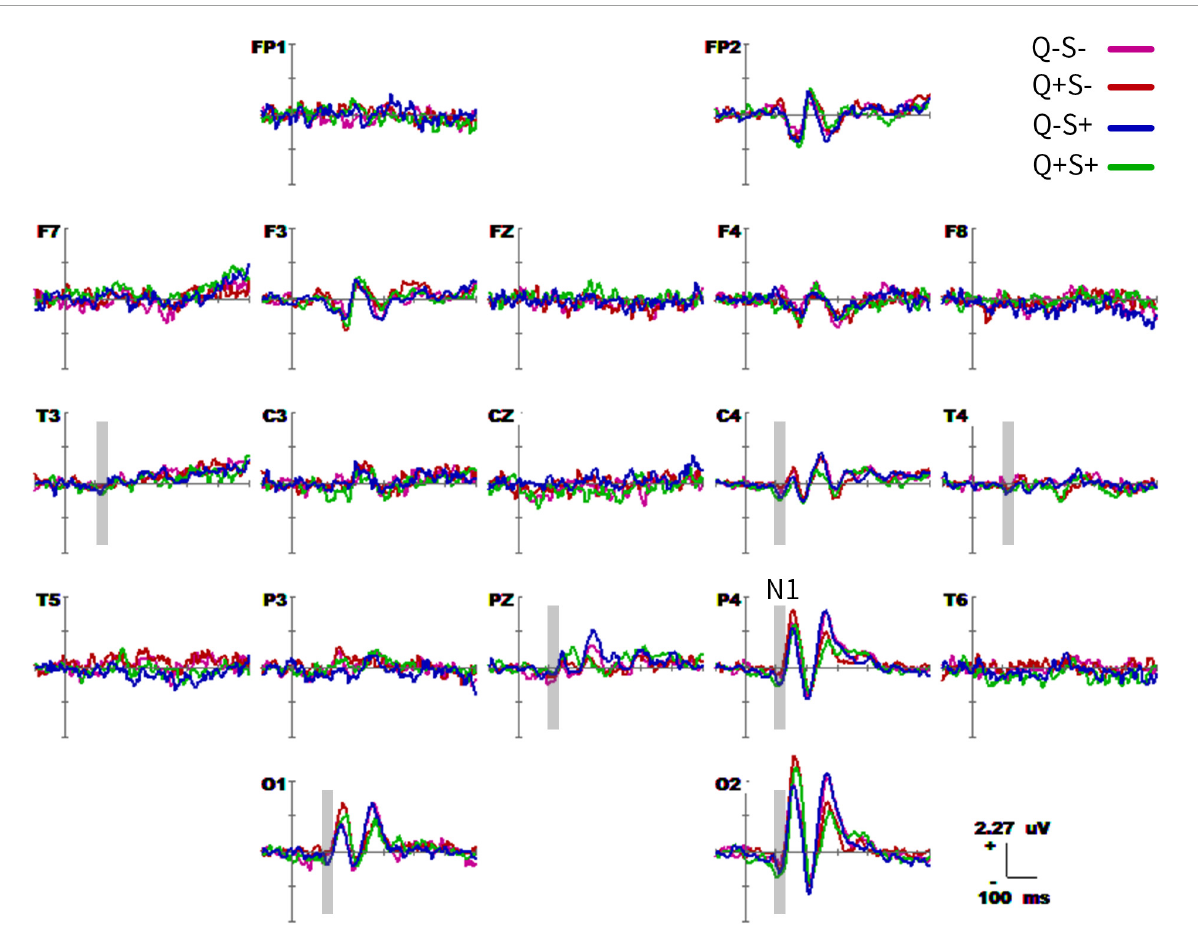
FIGURE5 Grand average event-related potential (ERP) waveforms (from –100 to 600 ms) are shown for 19 electrodes across four trial types. The purple, red, blue, and green traces correspond to group average ERP of the singular – inanimate (Q–S–), plural- – inanimate (Q + S–), singular – animate (Q–S +), and plural-animate (Q + S +) conditions, respectively. The baseline ERP measurement is the mean amplitude of a 100-ms pre-stimulus